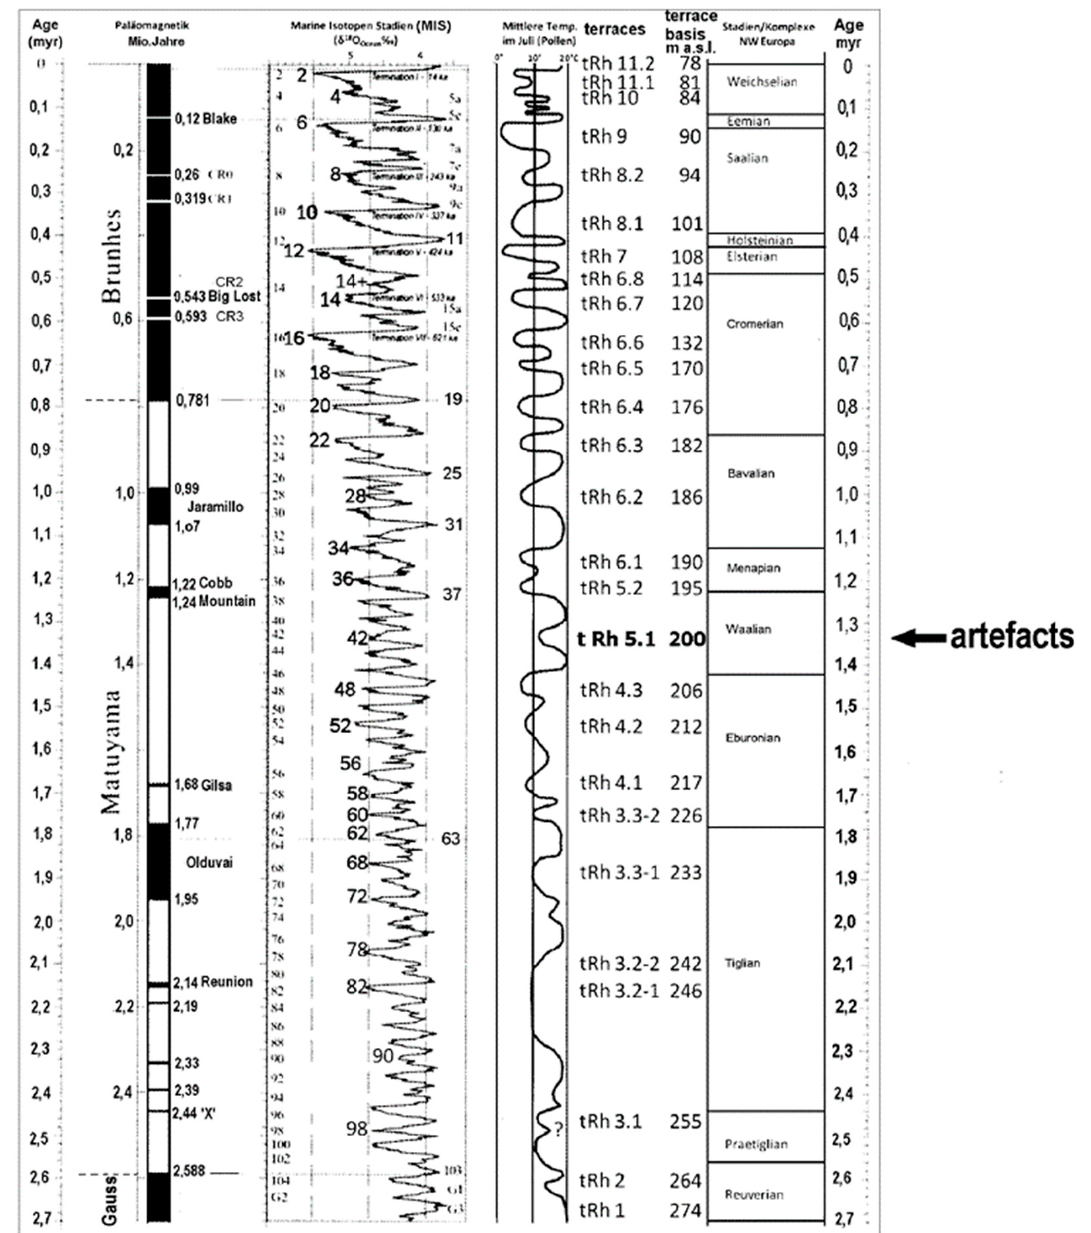
Figure 2. The terraces of the upper Middle Rhine and Lower Nahe. Black letters: tRh / Na 5.1 (After Preuss et al. 2015, modified). This table applies only to this region, because its terrace sequence is the result of the special geological uplift of the Hunsrück Massive during the Pleistocene.